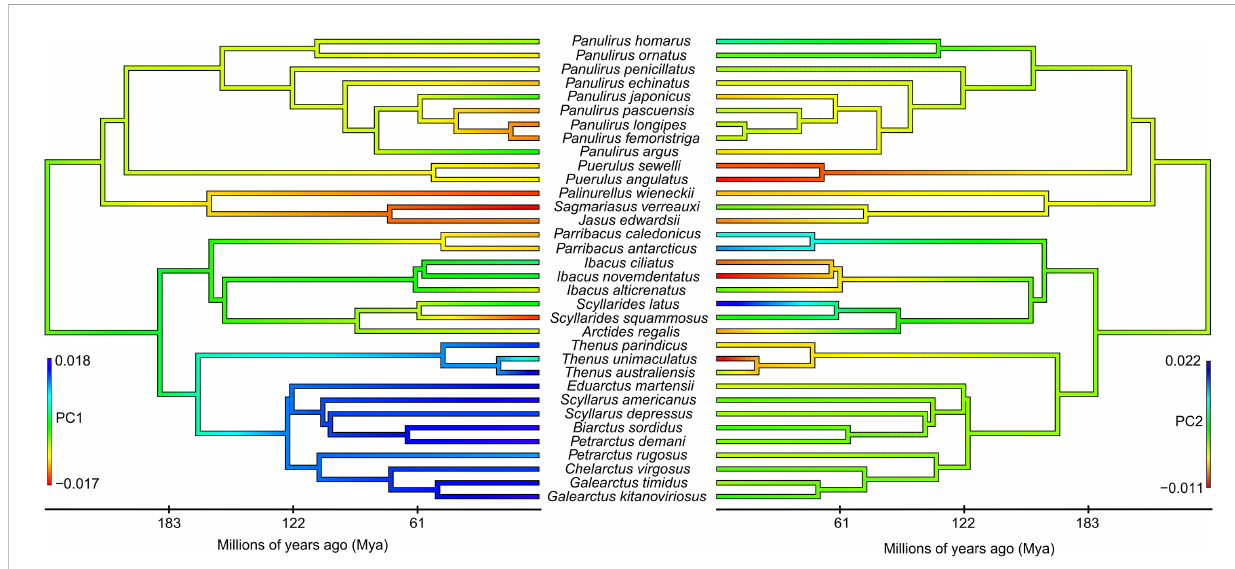
FIGURE 6 Ancestral state reconstruction of PC1 (left) and PC2 (right). Legends depict reference values for colour gradients in contour-map phylogenies and scales indicate ages in millions of years ago